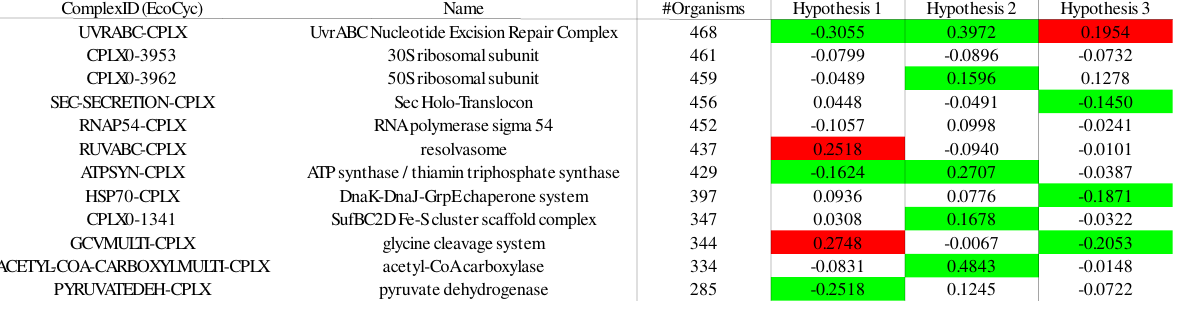
Table 2. Excerpt of validation results. The table shows the partial correlation for the three postulated hypotheses between operon size and factors influencing protein synthesis capacity (1: number of protein coding genes, 2: number of rRNA genes, 3: average CAI of protein complexes) of exemplary protein complexes of the EcoCyc database. Coloring indicates significant correlations in the predicted direction (green) and in the opposite direction (red). In the third column, the number of organisms is depicted in which a homolog was found. ComplexID